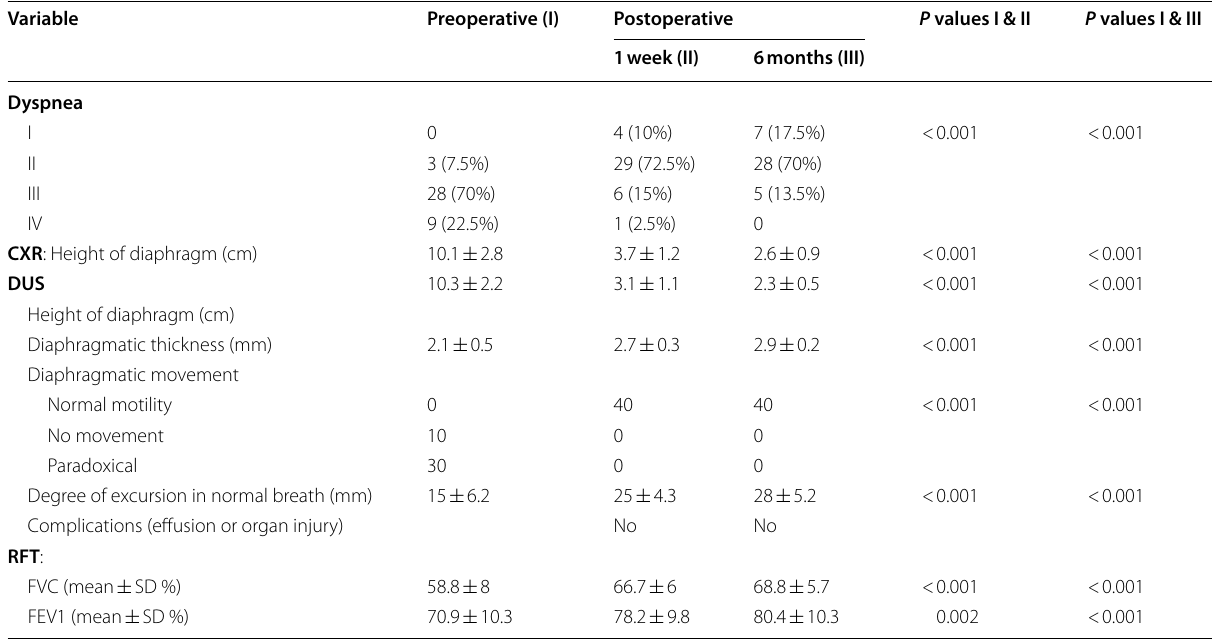
Table 2 Comparison between the preoperative dyspnea, CXR, DUS, and RFT, and the postoperative follow‑up at 1 week and 6